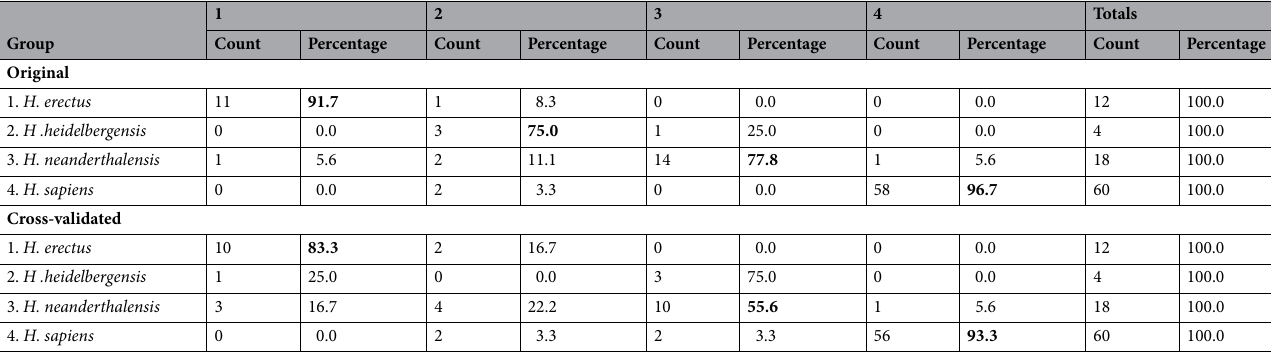
Table 2. Classification matrices of the original DA and cross-validated prediction of 94 human mandibles.